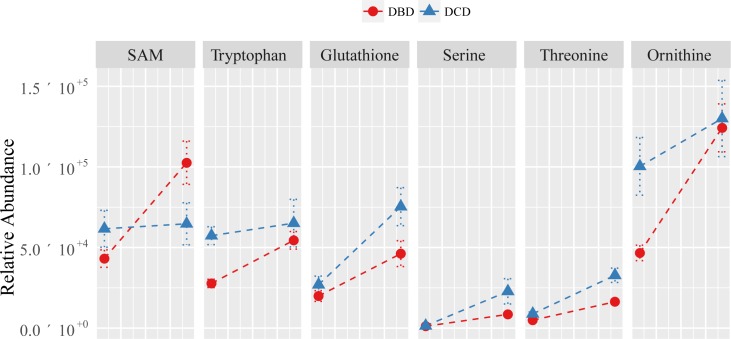
Selected top putatively identified metabolites changed in a significantly different way from the cold phase (T1) to post-reperfusion (T2) between DCD and DBD grafts.Gain Scores Analysis (Kruskal-Wallis on gain scores) was used to discover those metabolites that changed in a significantly different manner from cold-phase to post-reperfusion between the DCD and DBD grafts.